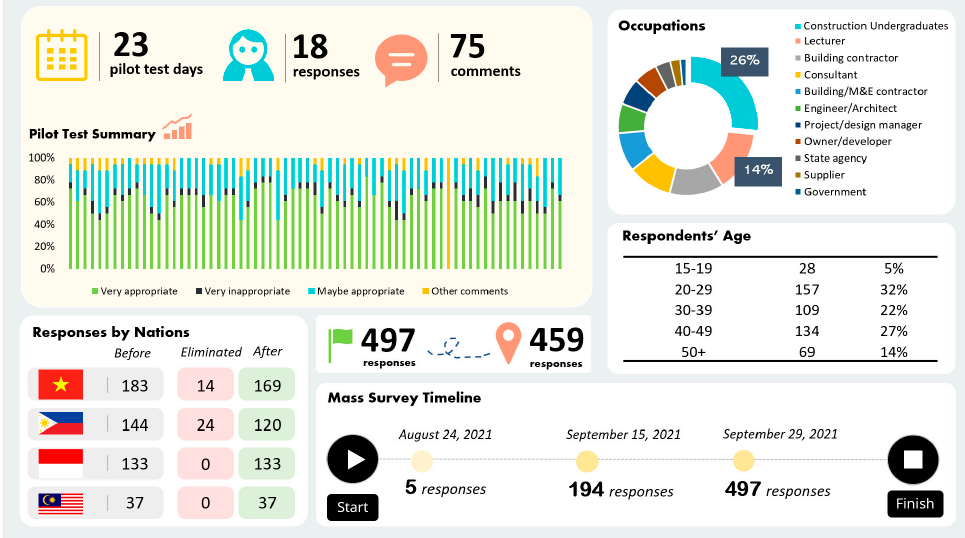
Figure 3. Pilot test and mass survey records.